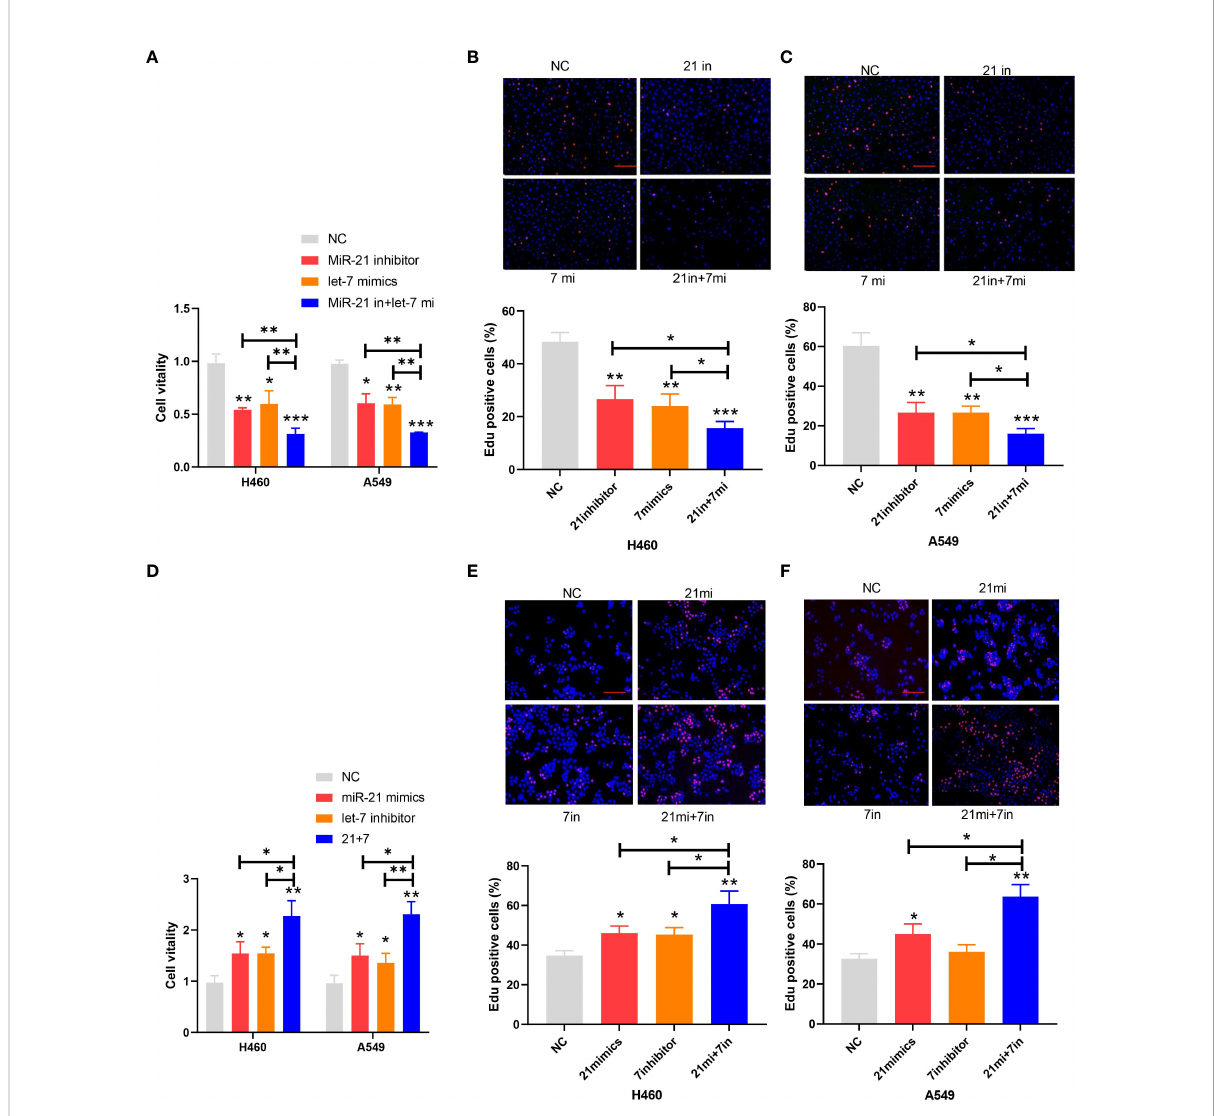
FIGURE 2 Proliferation of lung cancer cell lines. (A – C) Cell viability after transfection of the miR-21 inhibitor and let-7 mimic in lung cancer cell lines. (D – F) EdU cell proliferation after transfection of the miR-21/let-7 inhibitors or mimics in lung cancer cell lines (scale bar: 100 m m; * p < 0.05; ** p < 0.01; *** p <